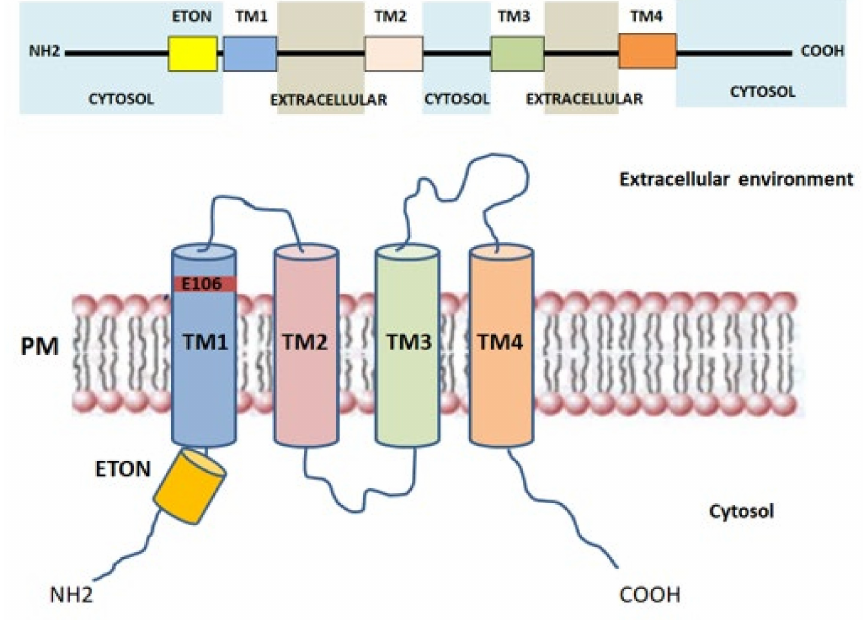
Figure 2. Schematic representation of a single Orai1 monomer with the four transmembrane (TM) regions, N - and C -terminus. TM—transmembrane; PM—plasma membrane; ETON—Extended transmembrane Orai1